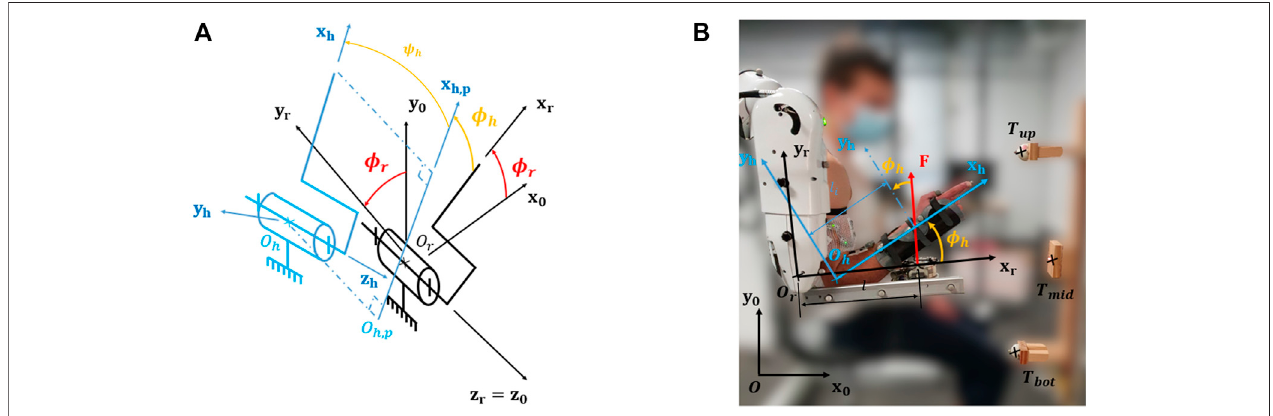
FIGURE 2 | Misalignments between human and exoskeleton. (A) General situation. (B) Sagittal plane case